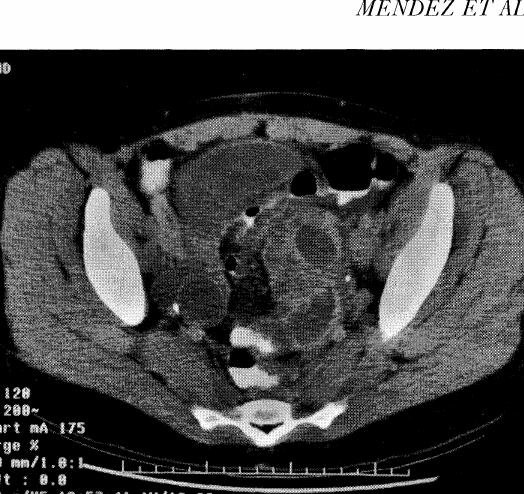
Fig. I. Computed tomographic scan of the pelvis showing complex pelvic